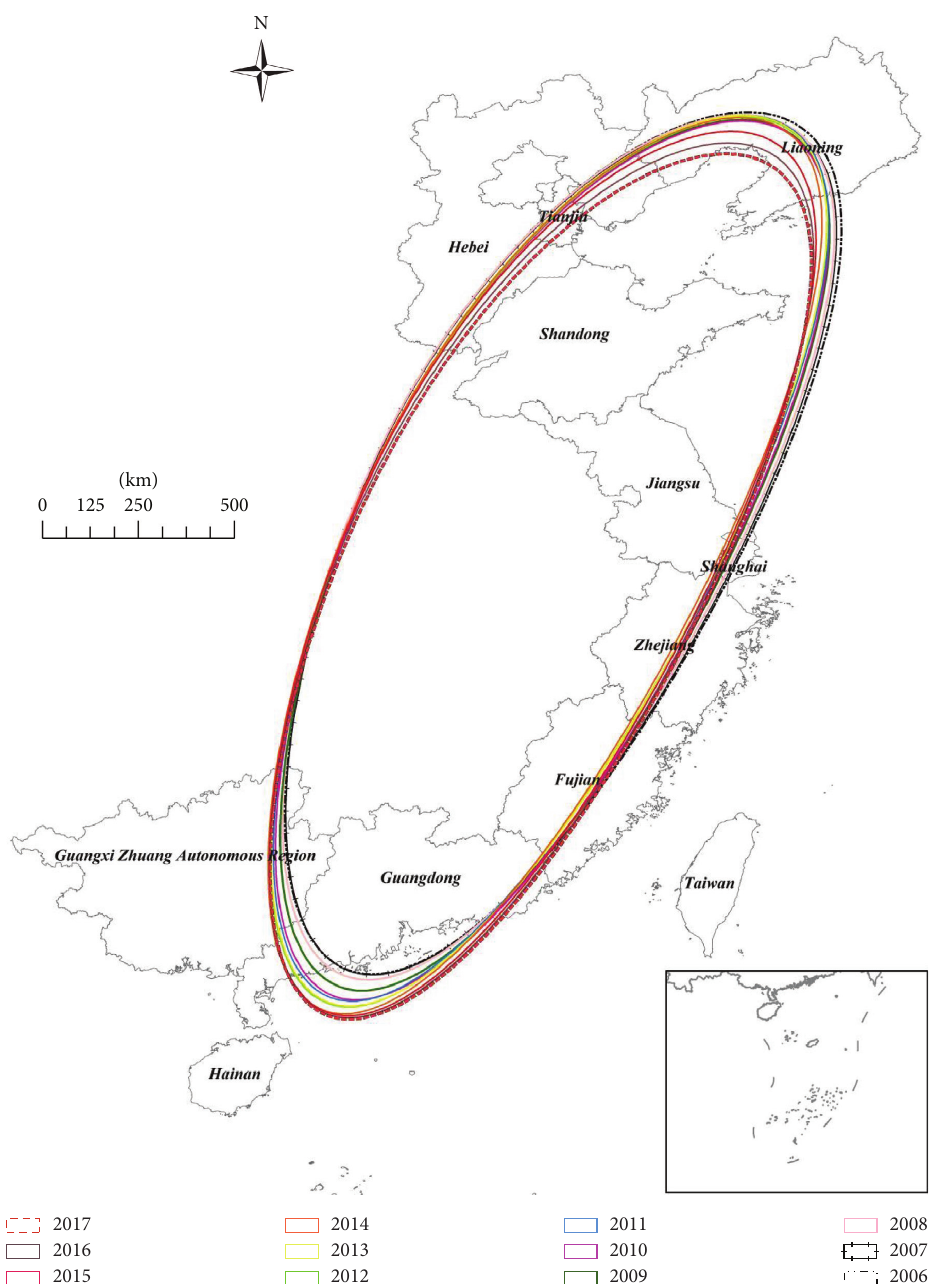
Figure 3: The spatial change of the center of gravity of marine economic efficiency between 2006 and 2017: ellipse